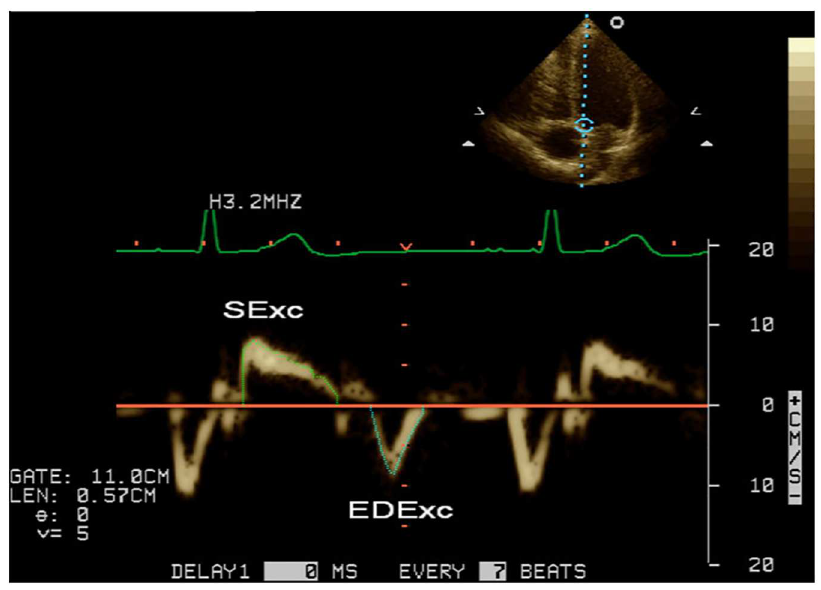
Fig 1. Example of the method for tracing the velocity time integrals of the systolic and early diastolic tissue Doppler signals from the mitral annulus.